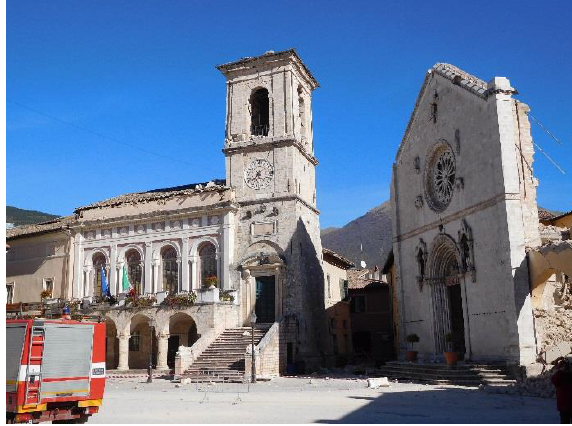
Figure 2. Civic Tower and the façade of San Benedetto